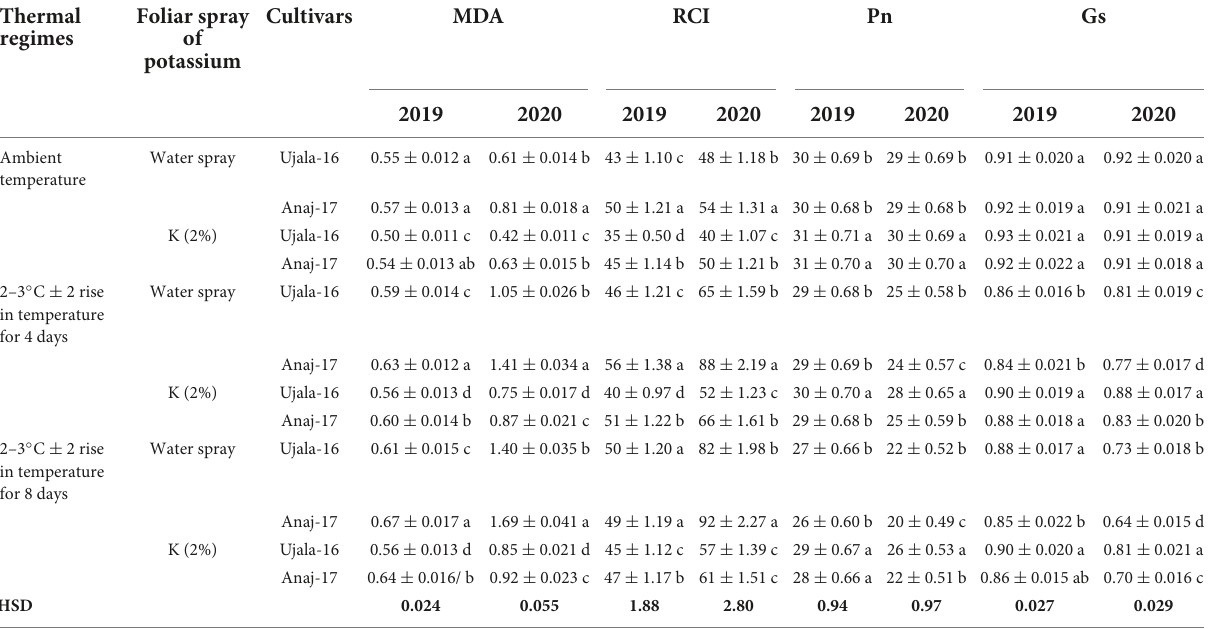
TABLE 2 Effect of optimal and stressful conditions of pots, potassium (K) spray, and cultivars on malondialdehyde (MDA nmol g − 1 FW), relative cell injury (RCI%), net photosynthetic rate (Pn µ mol m − 2 s − 1 ), and stomatal conductance (Gs m mol m − 2 s − 1 ) of wheat flag leaves under 4 and 8 days of heat stress 1 week after